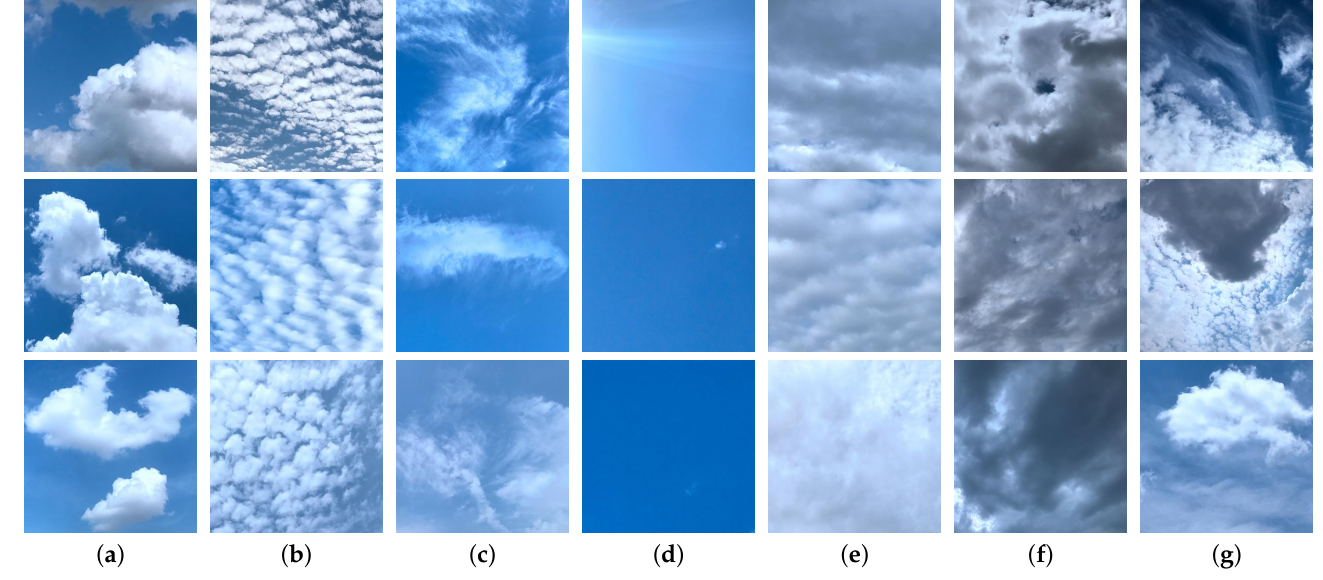
Figure 5. Example images from 7-class GCD dataset: ( a ) Cumulus, ( b ) Altocumulus and Cirrocumu- lus, ( c ) Cirrus and Cirrostratus, ( d ) Clear Sky, ( e ) Stratocumulus, Stratus and Altostratus, ( f ) Cumu- lonimbus and Nimbostratus, ( g ) Mixed